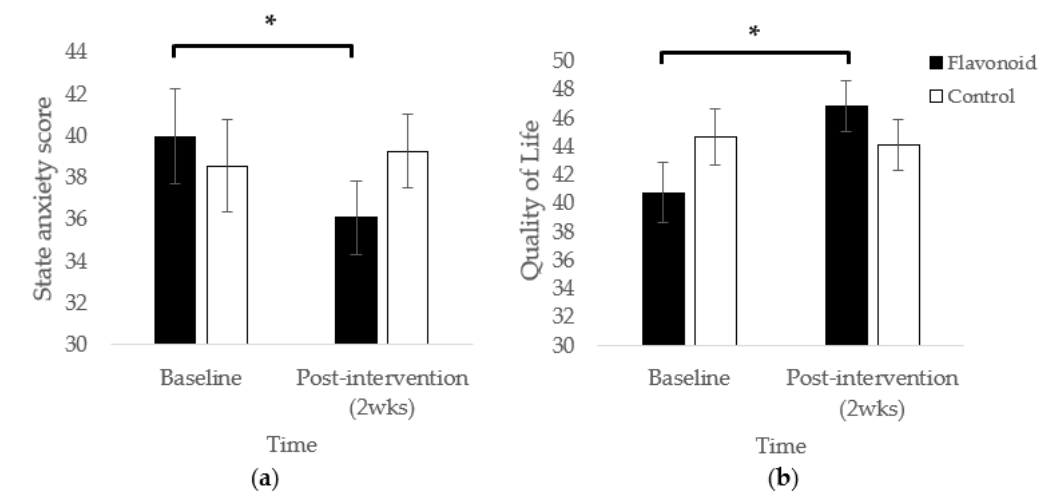
Figure 1. ( a ) Mean (SEM) state anxiety was significantly lower for mothers at 2 weeks compared to baseline (F(1,32) = 5.93, p = 0.02); ( b ) Mothers in the flavonoid group rated mean (SEM) quality of their physical health as significantly better at the end of the intervention compared to baseline ( p < 0.01). * p = 0.01.